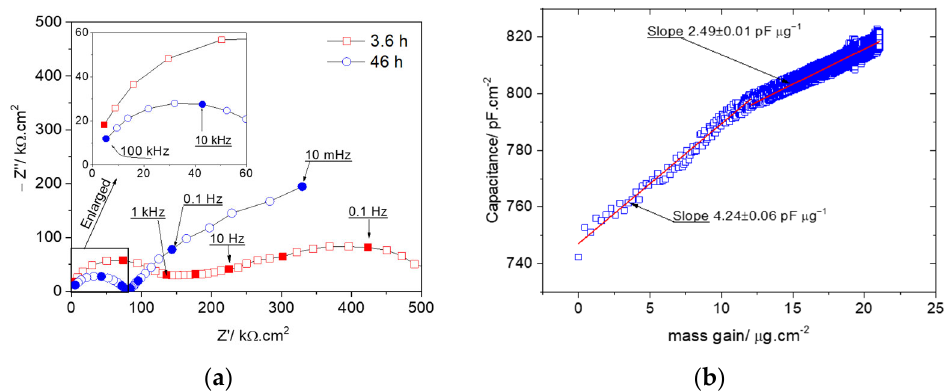
Figure 3. ( a ) Typical impedance plots obtained during a coating’s water uptake [32]. ( b ) Relationship between the high frequency coating capacitance and the mass gain (water uptake) [33].